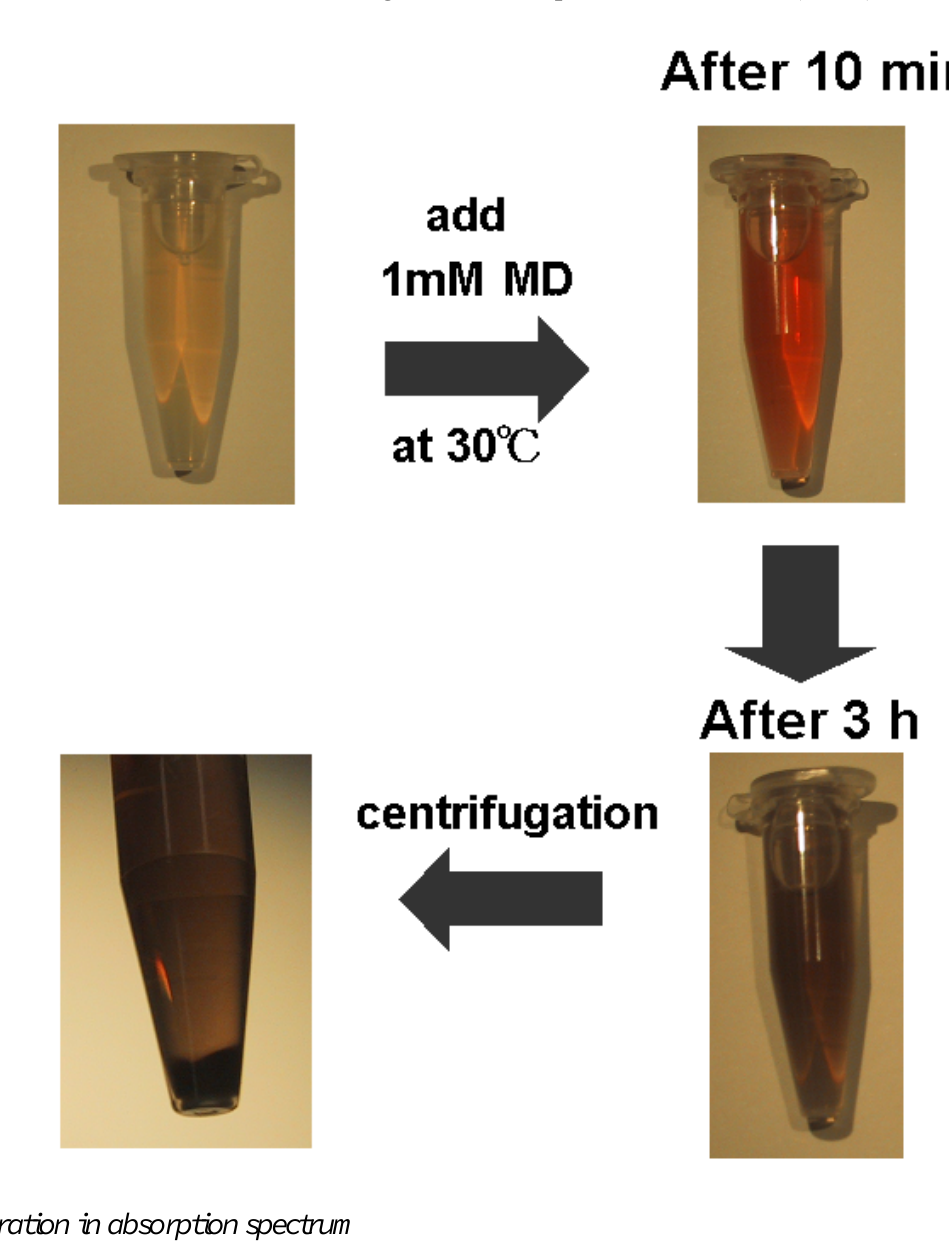
Figure 2. Alteration in coloring of banana supernatant with MD (1mM) during 3